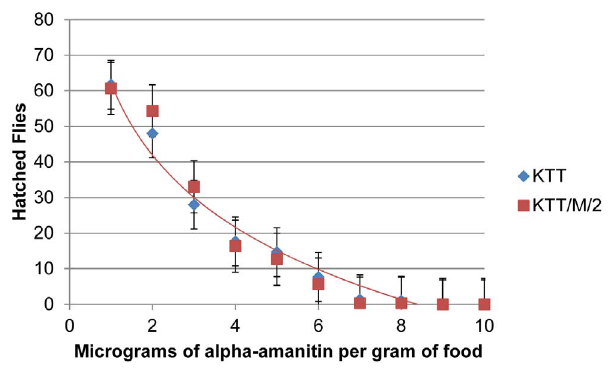
Figure 1. Ama-KTT/M/2 is not less resistant to a -amanitin than Ama-KTT. Ten first-instar larvae were placed on each a -amanitin concentration. The dose response curve shows the percentage of hatching flies. Error bars indicate the s.e.m. of three replicates.